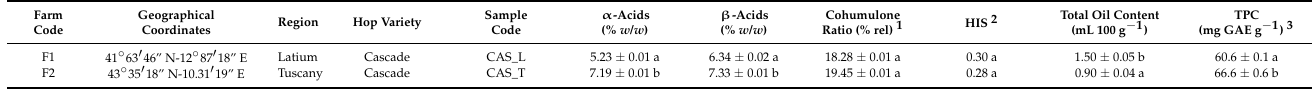
Table 1. Main features of hop farms and hop